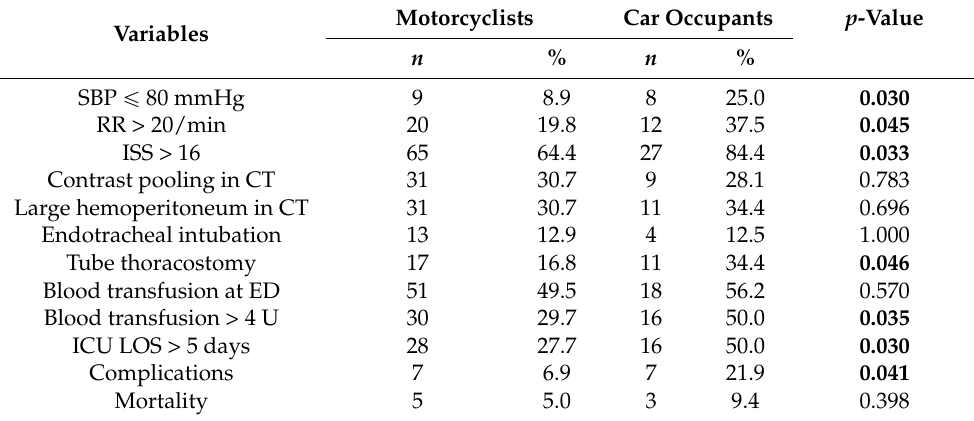
Table 2. Clinical presentation in motorcyclists and car occupants with high-grade BHSI.